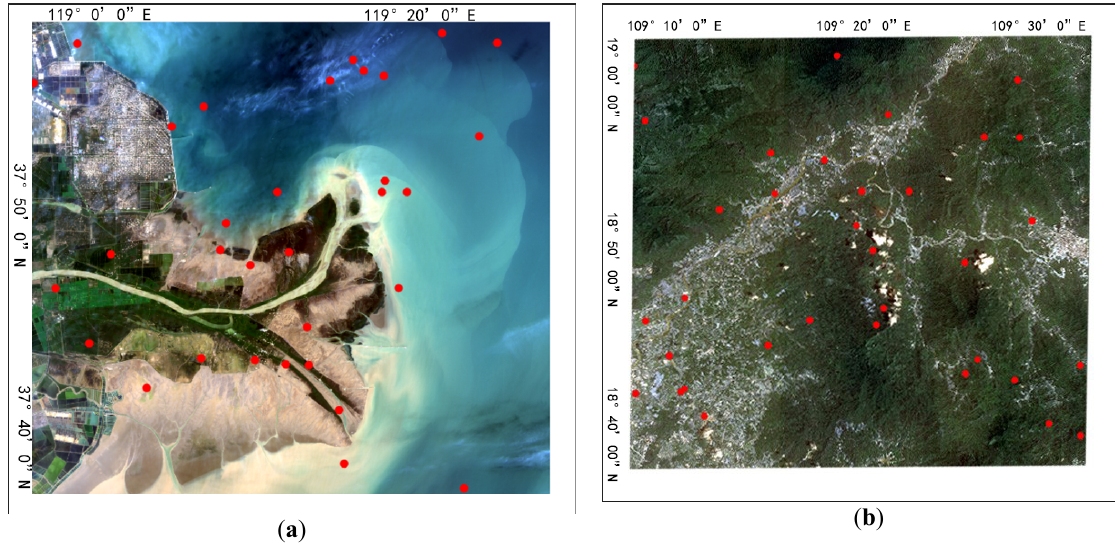
Figure 13. Checkpoints randomly selected on remote sensing images.